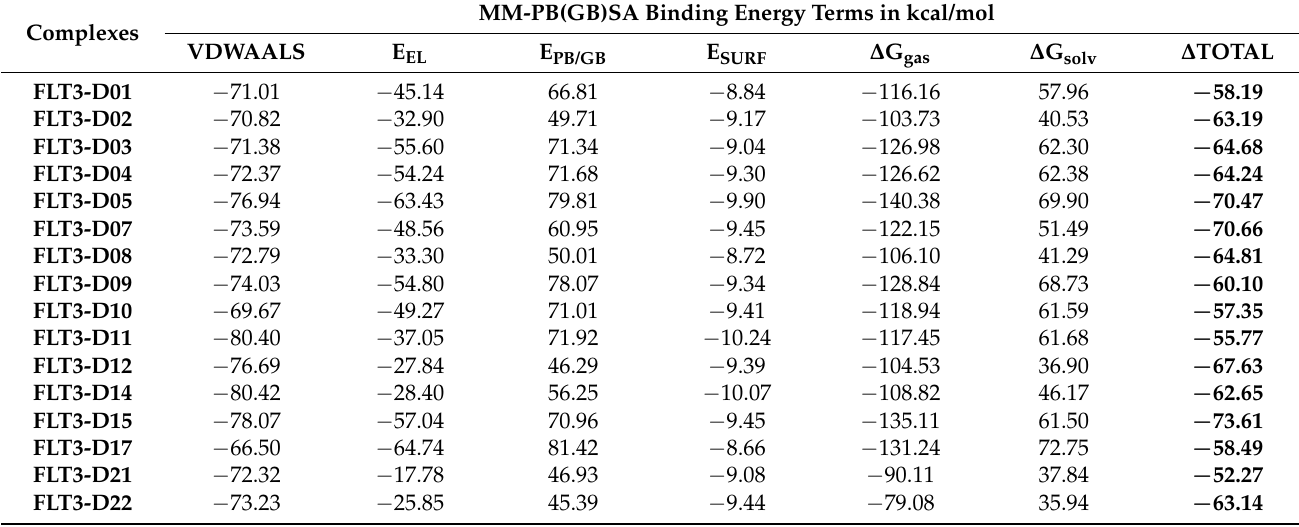
Table 5. MM-PB(GB)SA binding energy estimation between FLT3 and newly designed compounds.